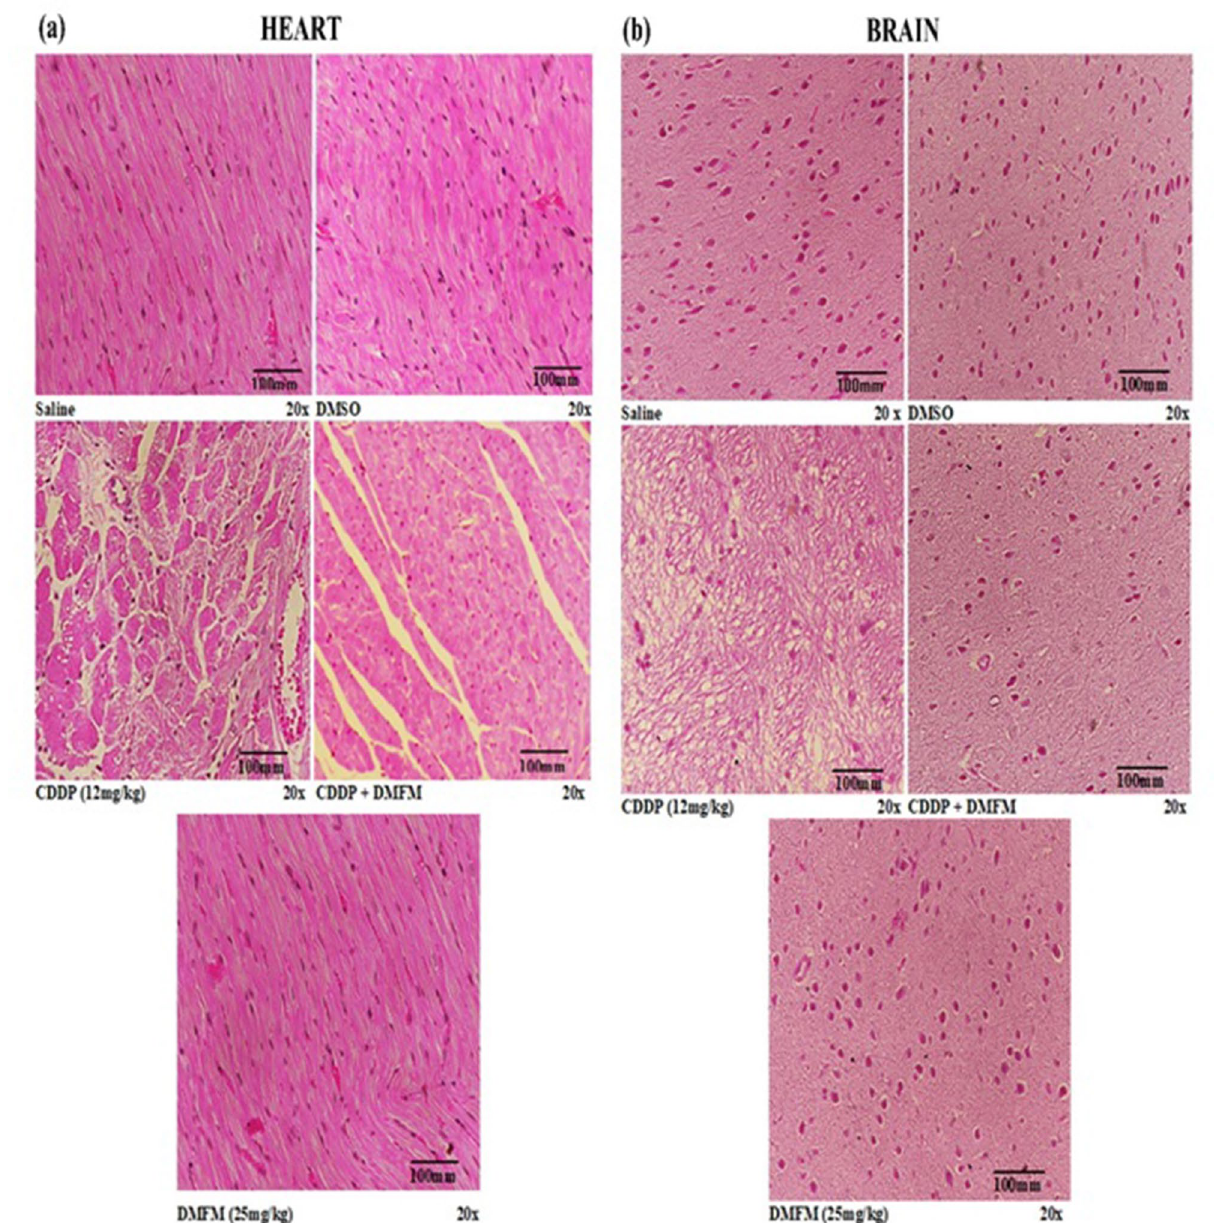
Figure 8. Representative H & E images of rat heart and brain from all treatment groups. ( a ) Cardiac muscle section from saline and DMSO groups displaying normal muscle fibers. CDPP-treated tissue sections depict greater cellular lesions and the presence of inflammatory cells. DMFM + CDDP treated heart induced significant injury. DMFM alone group exhibited regular morphology as in the saline group. ( b ) Brain sections from saline and DMSO groups presented typical morphology. CDPP-treated brain shows significant damage. DMFM treatment greatly improved brain tissue morphology. Treatment conditions are indicated at the lower left of each